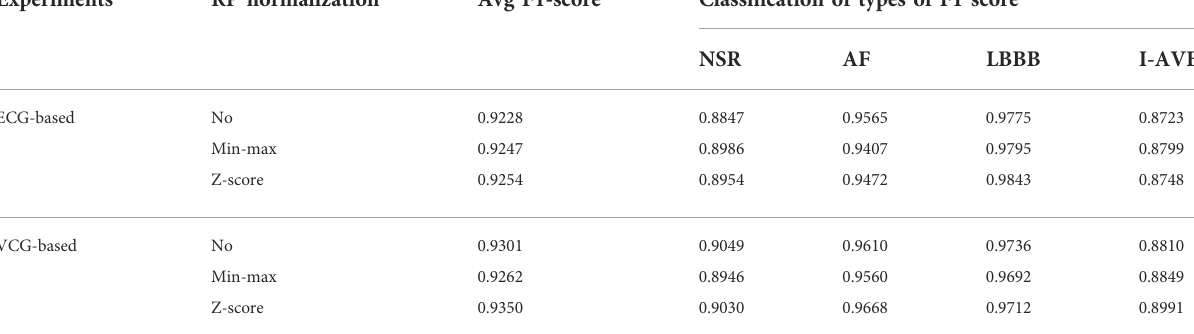
TABLE 2 Classi fi cation performance based on ECG and VCG 3DRP methods with No/Min-max/Z-score normalization datasets. Experiments